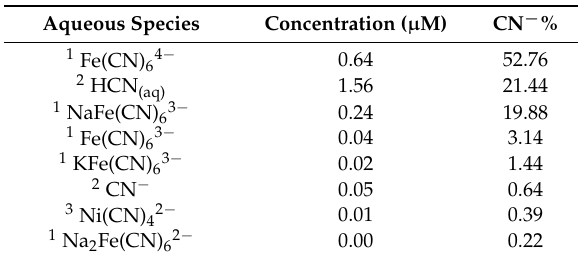
Table 4. Aqueous cyanide species for well #2 (E33-360), based on speciation modelling of well groundwater chemistry contemporaneous to the date of groundwater collection for this study. Strong-acid dissociable (SAD), weak-acid dissociable (WAD), and free cyanide account for 77.24, 0.40, and 22.37% of species,